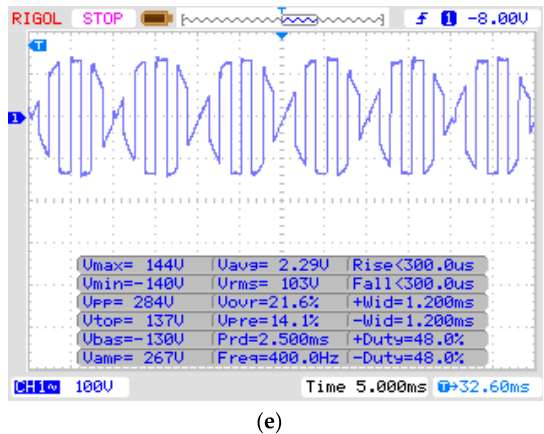
Figure 11. Outputs without ZCD: ( a ) switching signals; ( b ) input-output voltage waveforms; ( c ) FFT of the output voltage; ( d ) input voltage-current waveforms; ( e ) rms value of the output